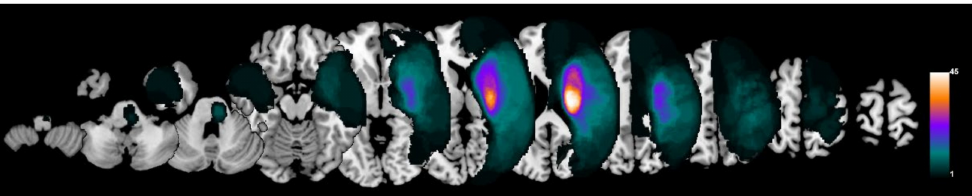
Figure 1. Lesion maps. The stroke lesions were flipped for patients with lesions on the right side. All lesions were overlaid on the left side.